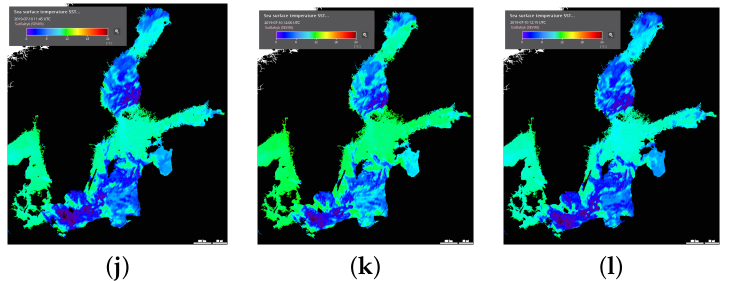
Figure 2. Diagram of the data set A.3 processing. The first row presents different maps of atmospheric transmission 10/July/2019, time UTC+02:00 for 11:45 ( a ), 12:00 ( b ), and 12:15 ( c ), gray scale. Black colors corresponds to the sea surface, dark grey to the land. The second row presents the transmission of cloud masks ( d – f ). Colors and their corresponding objects as follows: white—clouds, black—sea, dark grey—land). The third row ( g – i ) presents the results of the moment method. Yellow-white area is equally defined as cloudiness in both methods: yellow-black means overestimated area; white means underestimated area, black means not overcast area, and grey and yellow-grey means land. The fourth row presents SST maps ( j – l ).